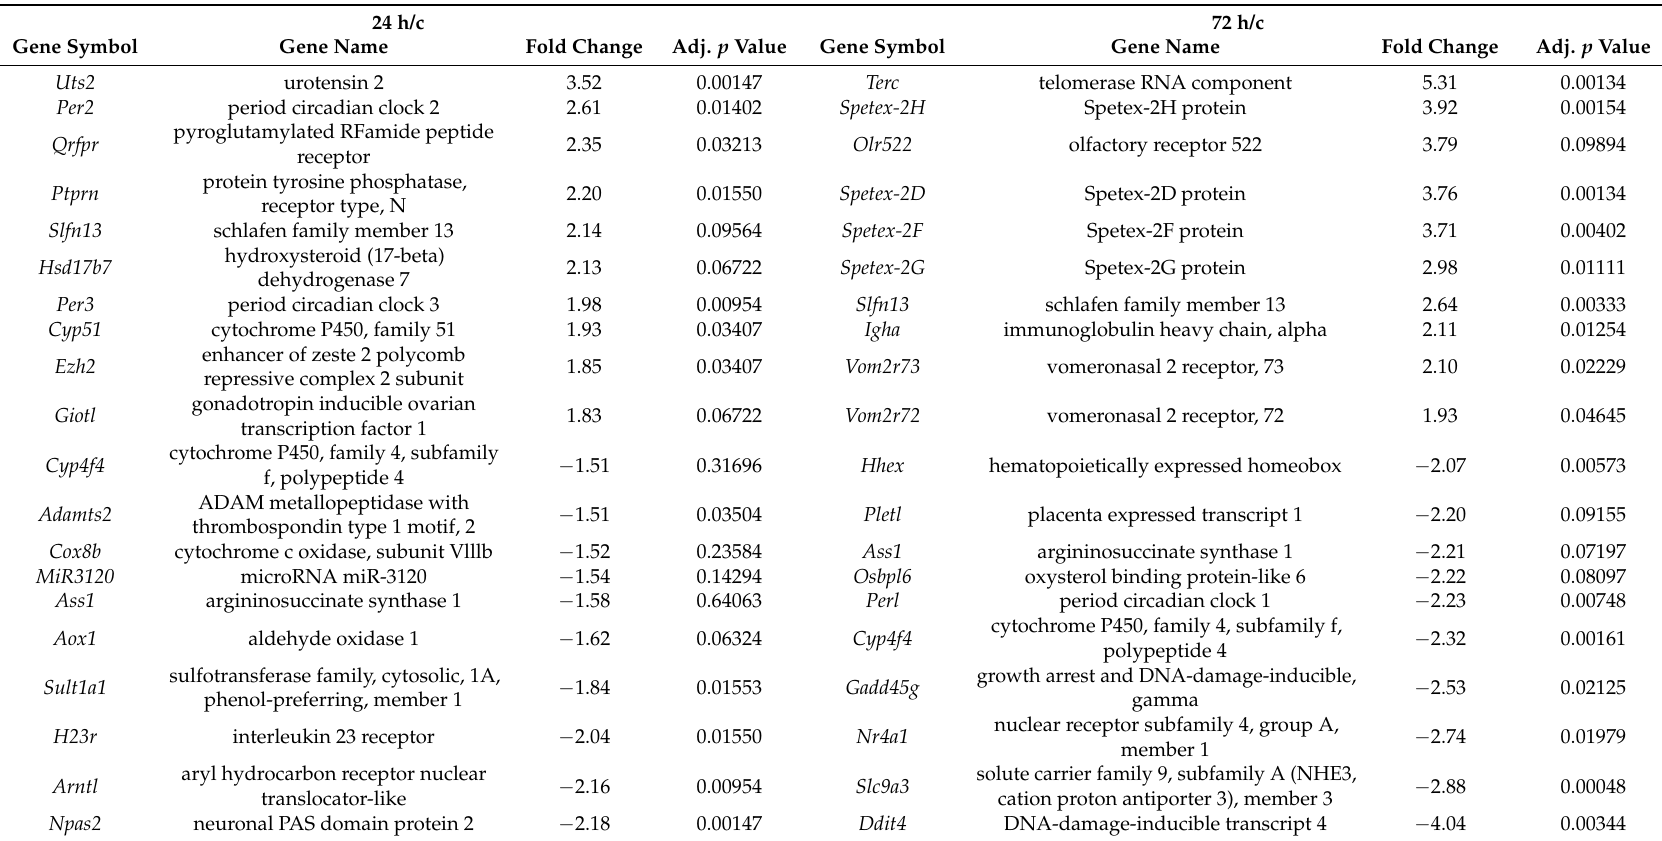
Table 1. List of 20 genes with the highest (10 genes) and lowest (10 genes) fold change obtained from the datasets of differentially expressed genes from 24 h/c (left) and 72 h/c (right)